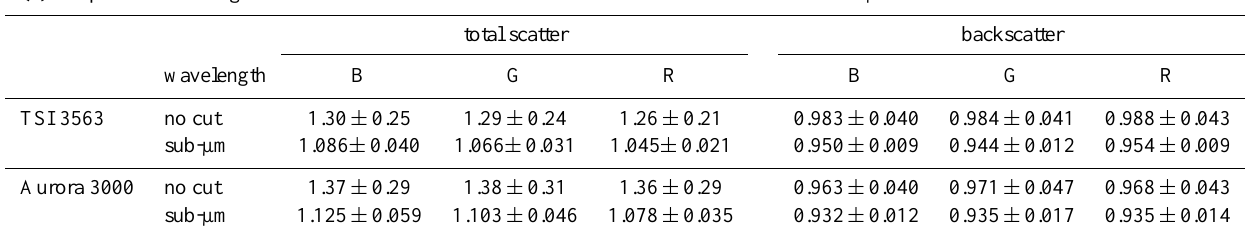
Table 3a. Nephelometer correction factors for angular nonidealities. Wavelengths for TSI 3563 are 450nm (B), 550nm (G), and 700nm (R), and wavelengths for Aurora 3000 are 450nm (B), 525nm (G), and 635nm (R), respectively. (a) Midpoint ± half range of calculated correction factors for conditions with and without sub-µm cut